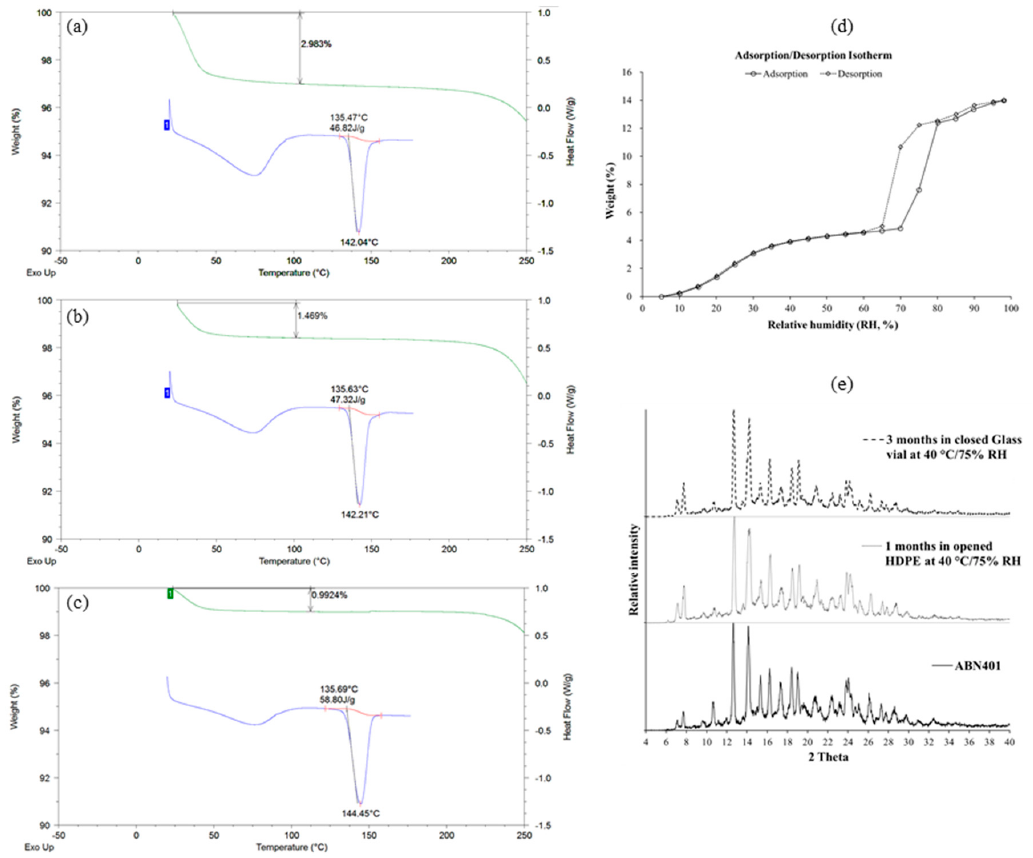
Figure 4. Thermal properties (TGA, green line (top) and DSC, blue line (bottom)) of ABN401 ( a ) from the first batch and ( b ) stored in open HDPE containers for 1 month at 40 °C, and ( c ) from second batch with relatively higher purity and less water content. ( d ) Dynamic vapor sorption (DVS) trends for ABN401 from second batch. ( e ) Powder X-ray di ff raction (PXRD) results for ABN401 from the second batch (bottom) and from the first batch at two di ff erent